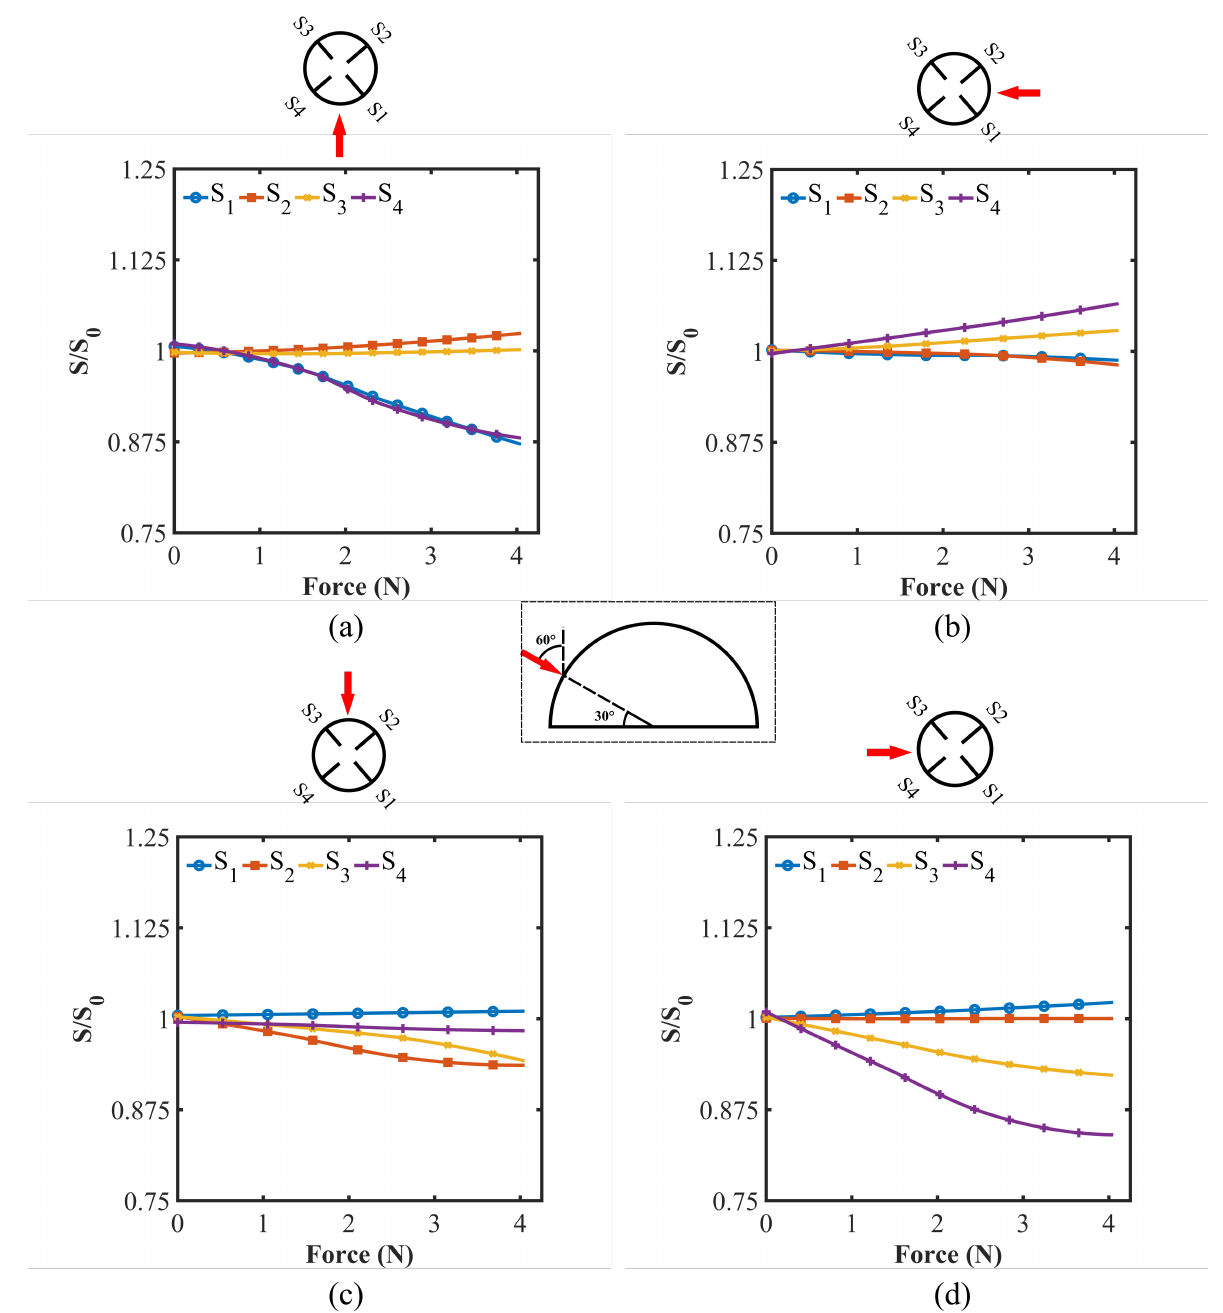
Figure 11. Force calibration against forces along 60 ◦ with vertical on the sides of the hemispherical sensor at 30 ◦ latitude (in between inserted two consecutive ( a ) S 4 and S 1 , ( b ) S 1 and S 2 , ( c ) S 2 and S 3 , and ( d ) S 3 and S 4 flex sensors); top view of the sensor system is exhibited and the red arrow shows the applied force